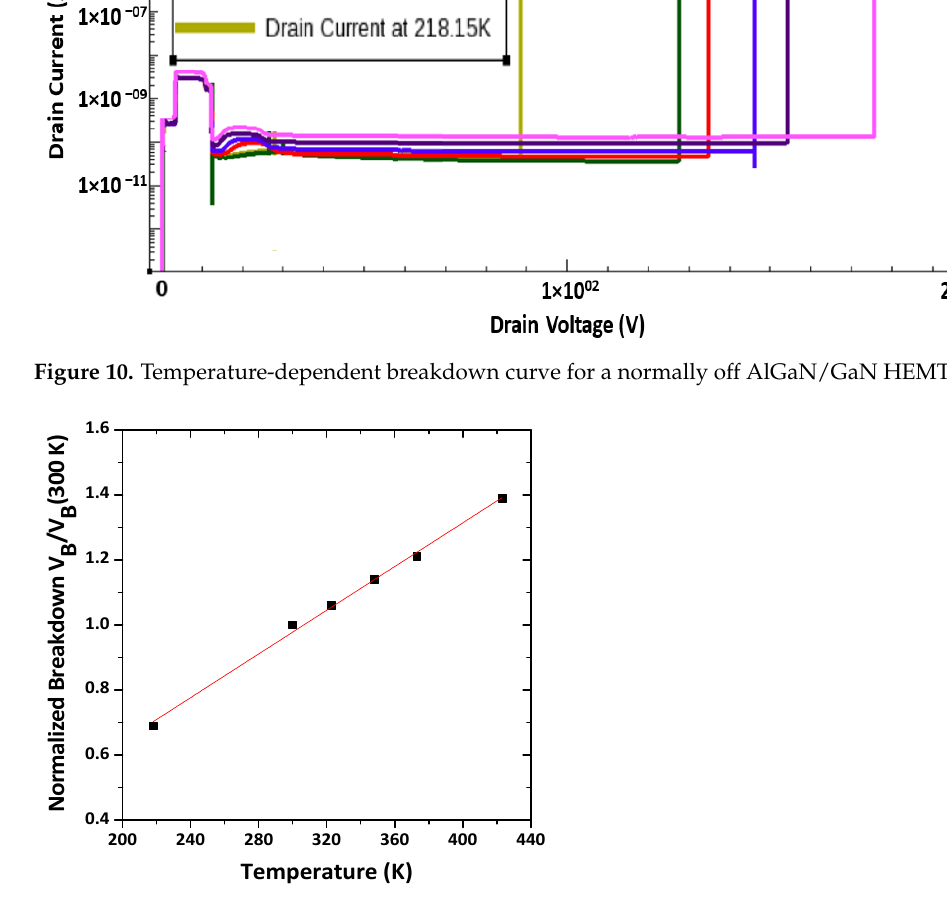
Figure 10. Temperature-dependent breakdown curve for a normally off AlGaN/GaN HEMT.